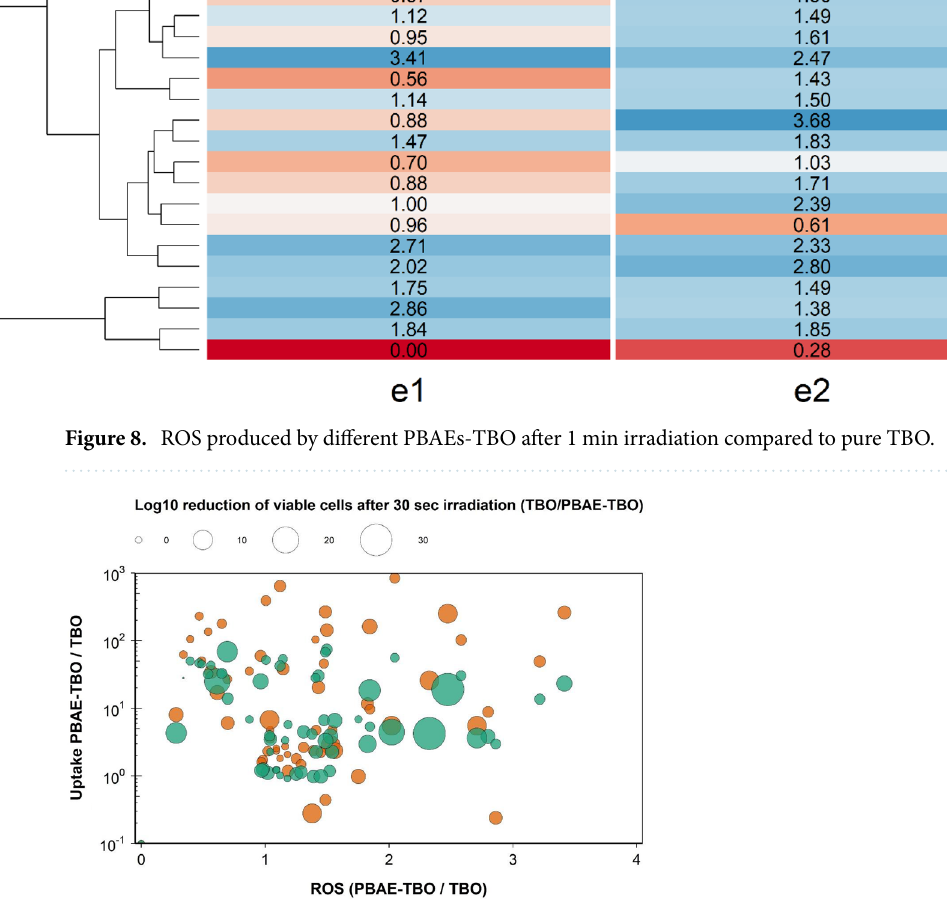
Figure 9. Correlation of ROS produced and TBO uptake on antimicrobial activity (ratio of log10 reduction after 30 s laser irradiation in the presence of TBO or PBAE-TBO) of E. coli (green circles) and S. epidermidis (orange circles) by different